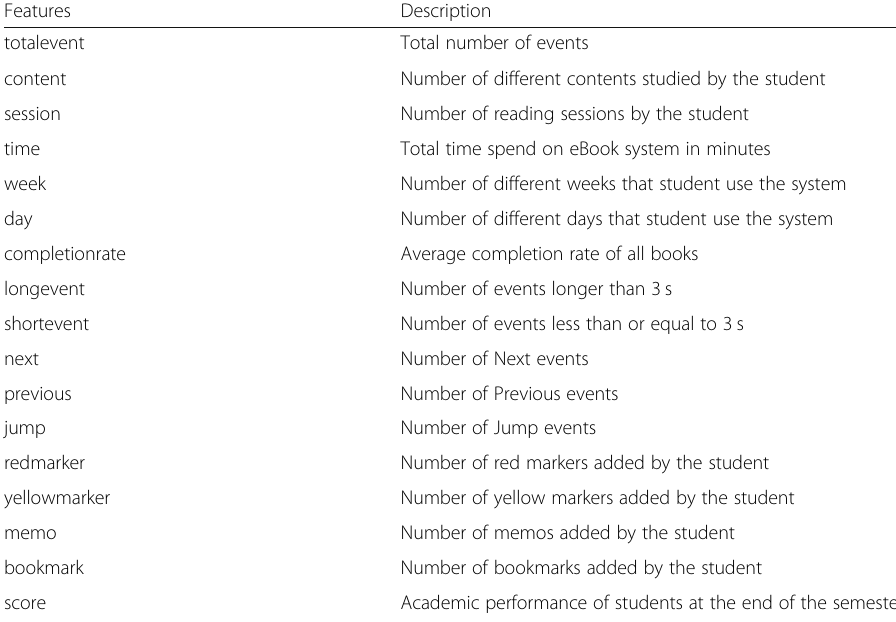
Table 2 Description of features used in prediction models